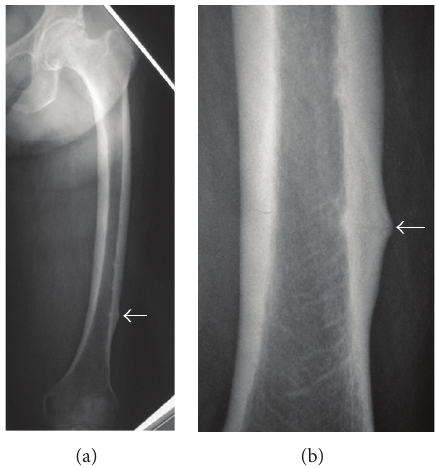
Figure 1: Anteroposterior radiographs of the left femur. (b) is a magnified view of (a). They showed some thickening of the femoral cortex and a horizontal line resembling a fracture over the outer cortical bone of the distal diaphysis.